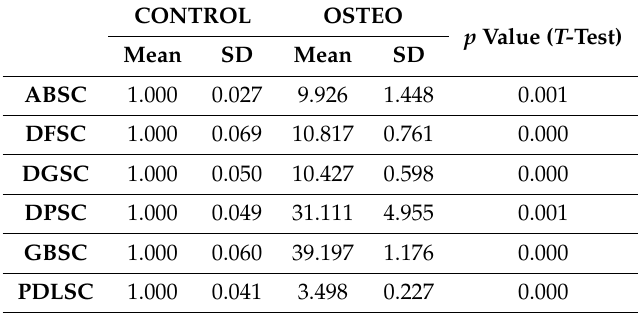
Table 3. Normalized detection of Alizarin Red staining after 28 days in osteogenic induction